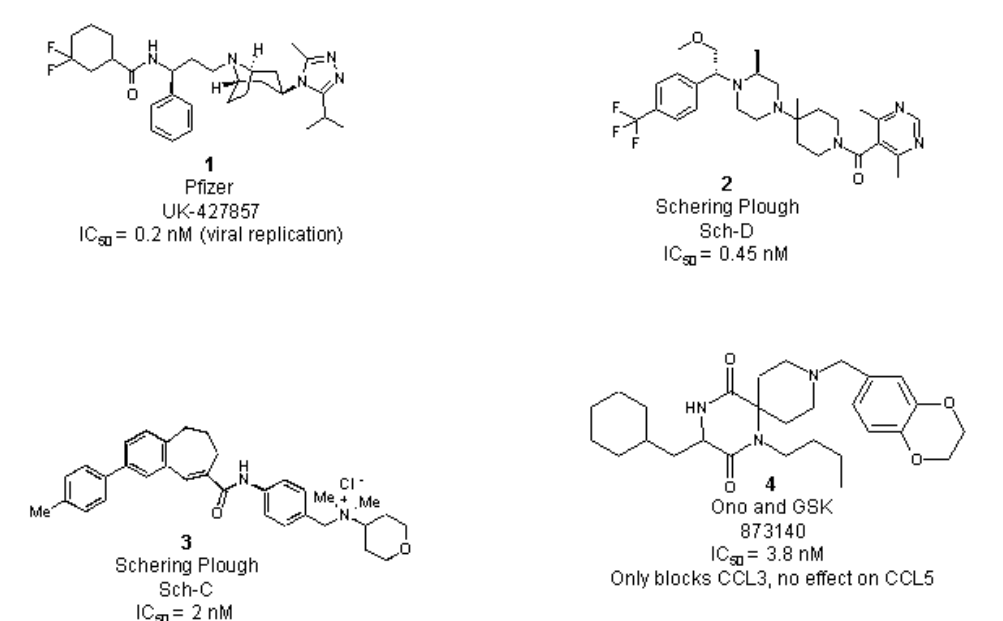
FIGURE 3. Structures of CCR5 antagonists - IC 50 reported for inhibition of 125 I -CCL5 binding to CCR5 expressing